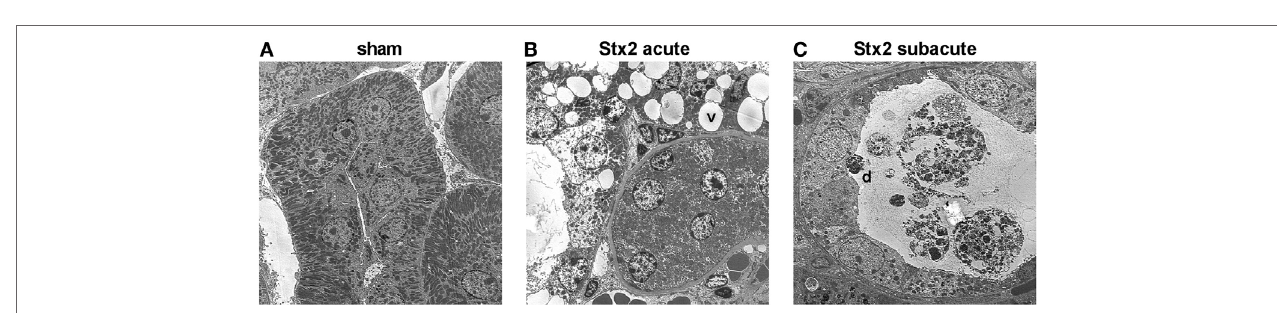
FigUre 9 | Electron microscopic analysis of kidney tissue from C57BL/6J mice subjected to different Stx2 regimens. Representative ultrastructural images of renal tubules show (a) no pathological changes in sham animals, (B) prominent vacuoles (v) in the acute and (c) pronounced tubular atrophy (d = detached tubular cell) in the subacute model. Magnification: 2,000 × ; ultrathin sections, n = 2 animals were studied per group.